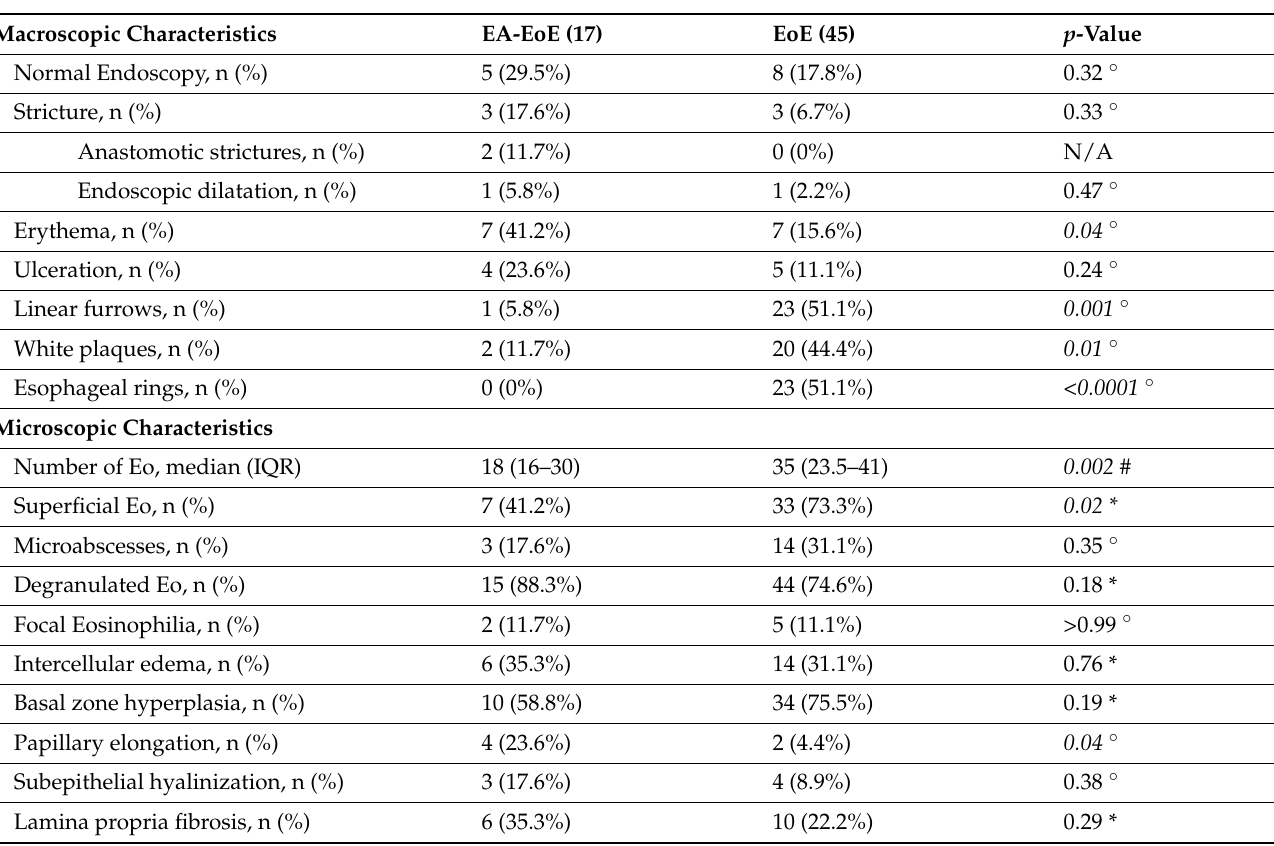
Table 3. Endoscopic and histologic signs at